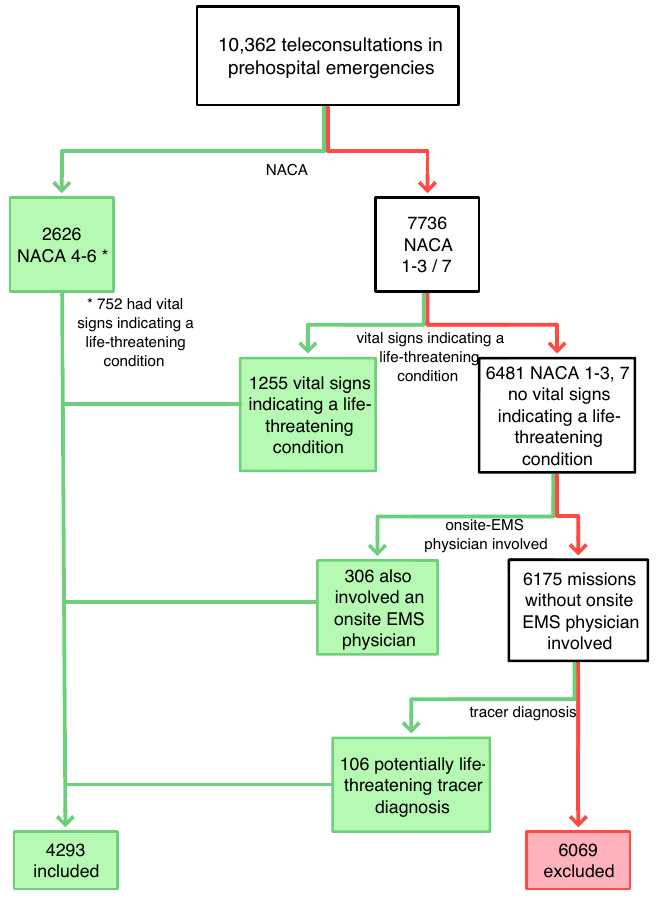
Figure 1. Flow chart of the inclusion of missions from all tele-EMS missions performed from 01/2015– 12/2018; red arrow = exclusion, green arrow =